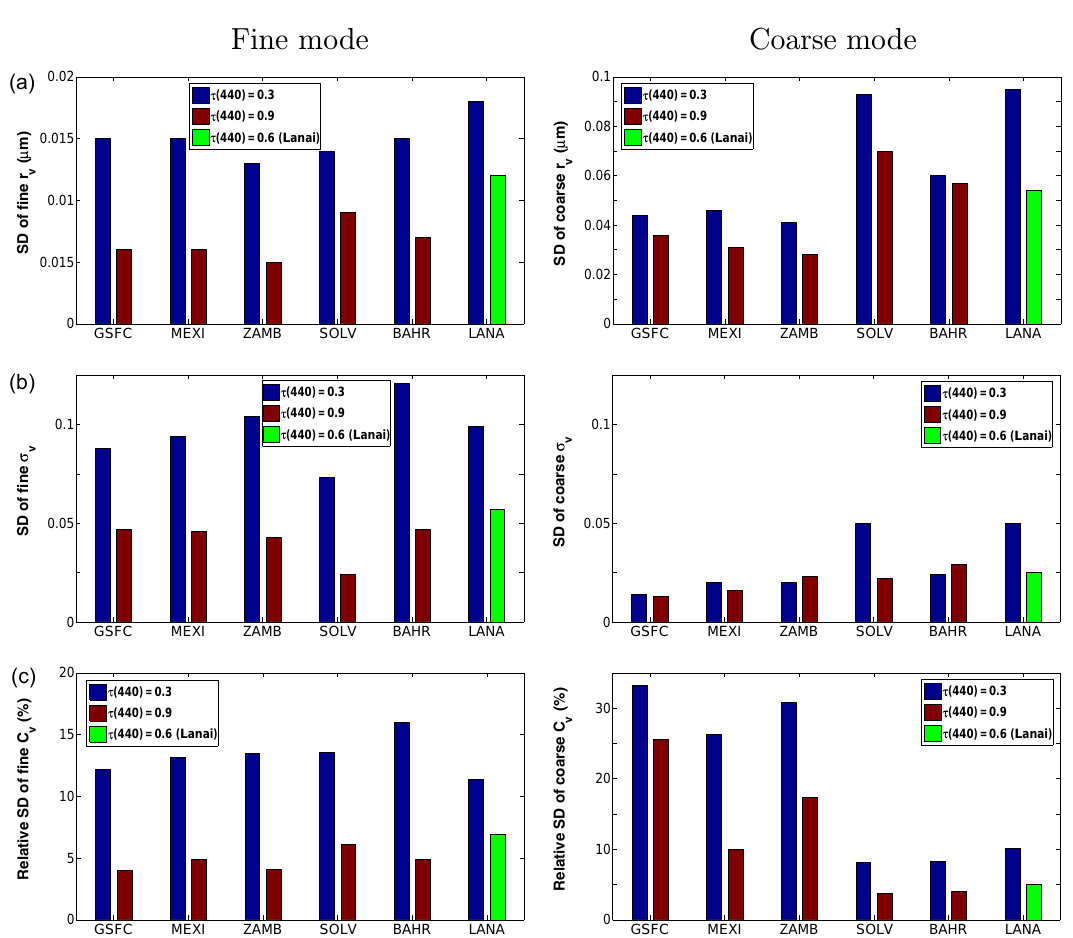
Figure 7. Standard deviation (SD) obtained in the error simulation study (Table 7) for the six parameters that describe the bimodal log- normal size distributions: volume median radius (a) , geometric standard deviation (b) and volume concentration (c) . For the latter, the standard deviations are plotted in relative